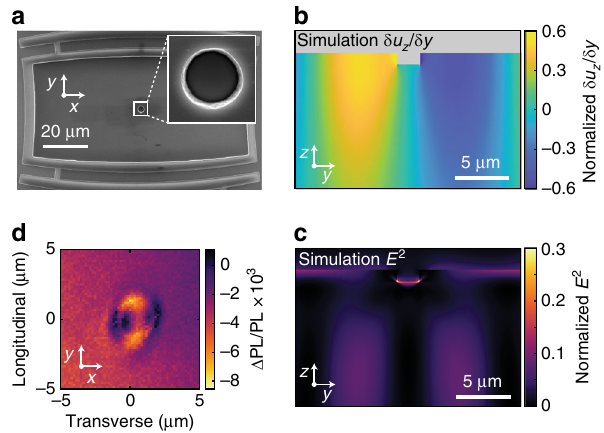
Fig. 3 Structural defect and internal piezoelectric response. a SEM image of model structural defect, an etched pit, located at the center of the SAW beam waist. b , c Simulated depth cross-section of the longitudinal lattice curvature and electric fi eld magnitude ( E 2 ) in the SiC substrate. The fi nite element models are computed using COMSOL Multiphysics and show a time slice during continuous RF excitation of the SAW. Although the etch pit is located at a node in longitudinal curvature, increased strain and piezoelectric effects happen at the pit ’ s base and corners. d Enhanced dynamic piezoelectric effects at the pit are independently and all-optically mapped by native quantum defects using Electrometry by Optical Charge Conversion 37 , which is sensitive to the local E 2 . Peaks of signal are visible at the longitudinal pit edges, and the background is from stray electric fi elds (see Supplementary Fig. 4 for depth dependence of PL